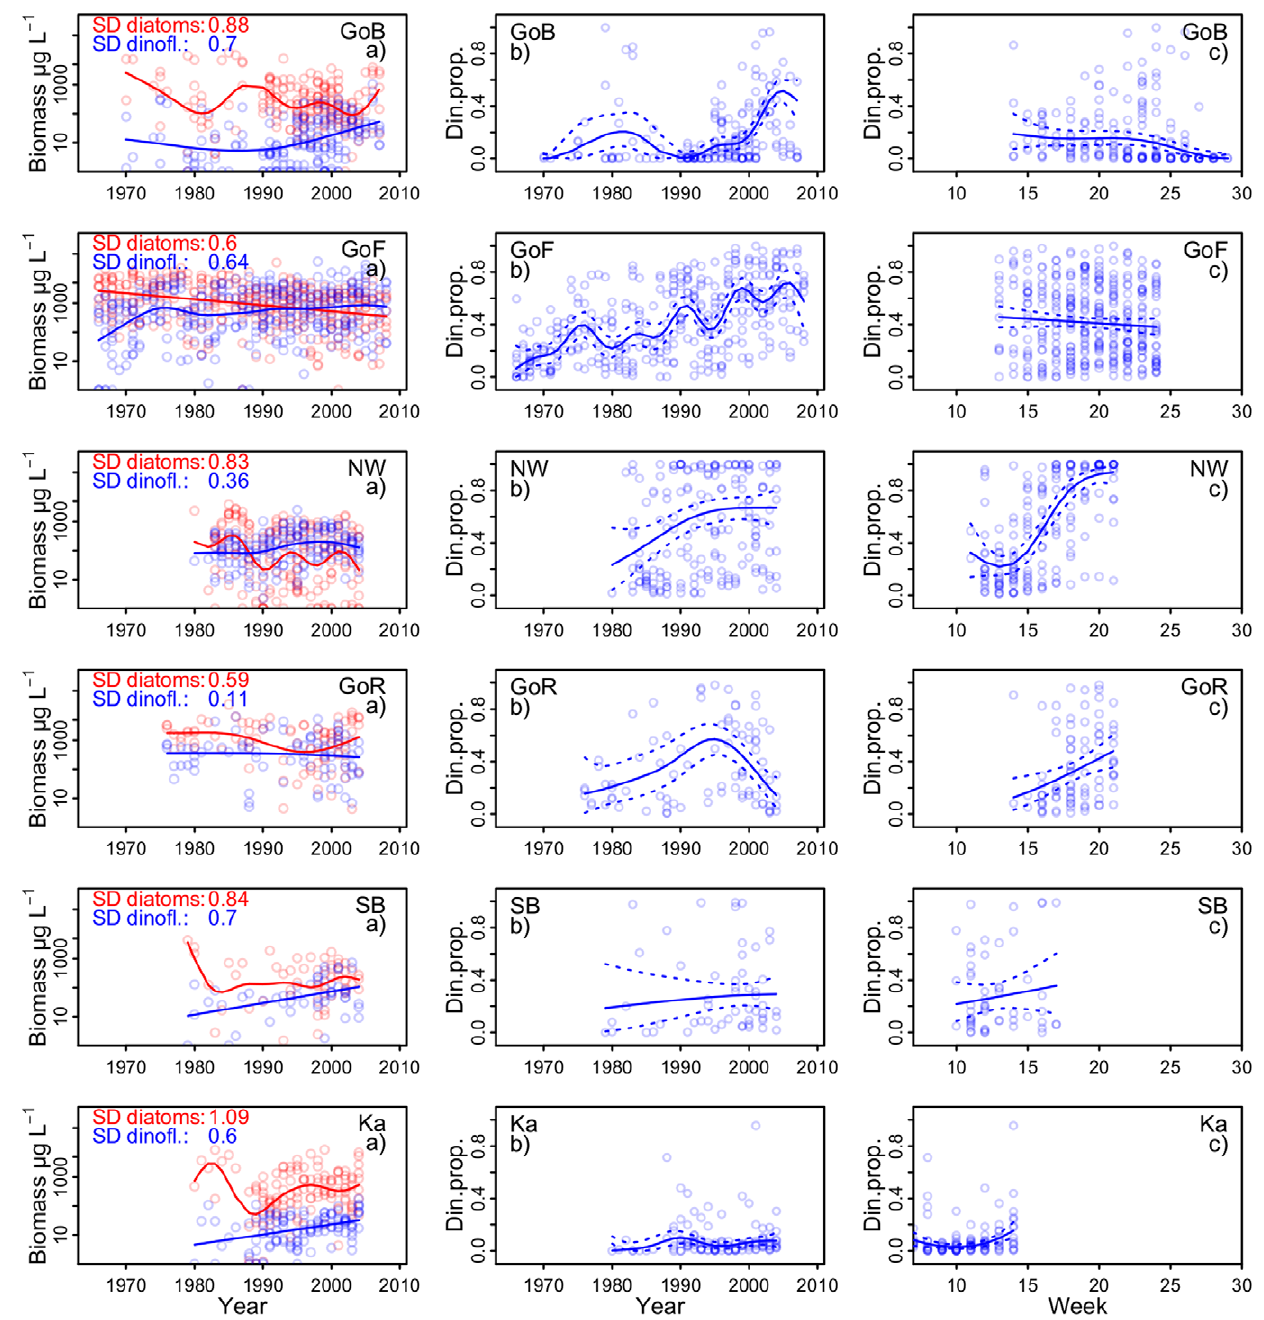
Figure 2. Long-term trends of diatoms and dinoflagellates in the Baltic Sea. Lines depict the long-term trends of dinoflagellate and diatom biomass (column a), dinoflagellate proportion (column b) and seasonal pattern of dinoflagellate proportion (column c) in six major basins of the Baltic Sea; GoB – Gulf of Bothnia; GoF – Gulf of Finland and Archipelago Sea; NW – northwestern Baltic Proper; GoR – Gulf of Riga; SB – Southern Baltic Sea; Ka – Kattegat, the Belt Sea and the Sound. Symbols represent basin wide weekly averages; trend lines are predicted by GAM smoothers. Eastern Gotland Basin is not shown due to poor data coverage.